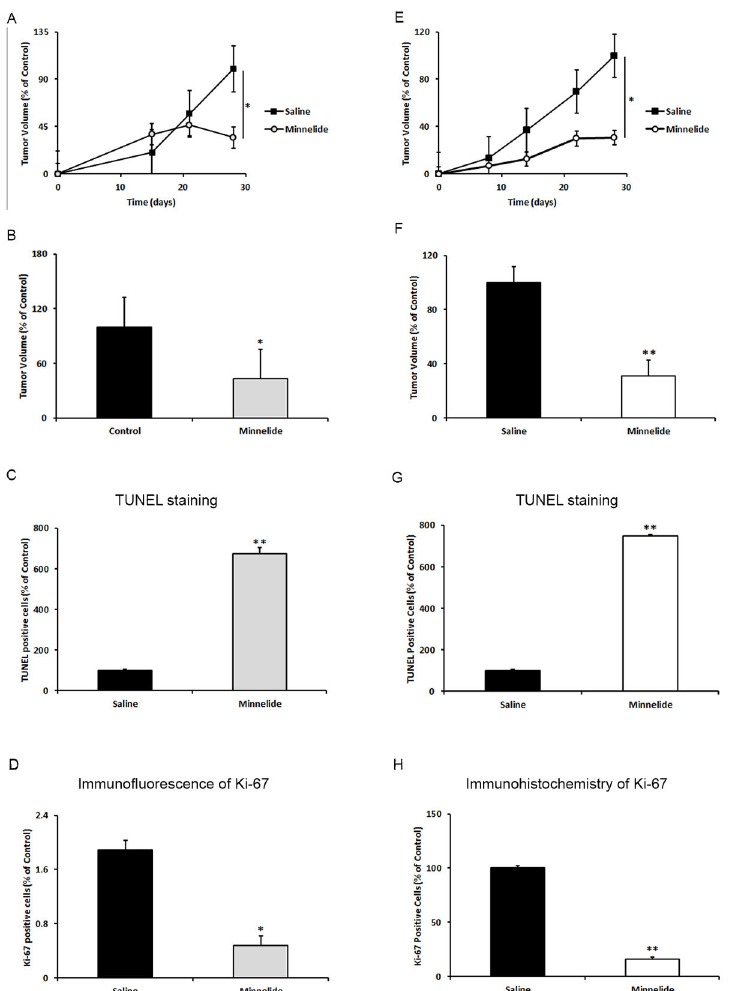
Figure 3. Minnelide leads to tumor regression in xenograft mouse models. In two xenograft mouse models, A549 (right panel) and NCI-H460 (left panel), tumor volumes were compared between minnelide treated (n = 10) and untreated groups (n = 10). Five days after tumor injection, mice began receiving daily intraperitoneal injections of minnelide at 0.42 mg/kg mouse weight. Control animals were injected with equivalent volumes of phosphate-buffered saline. Suppression of tumor growth occurred in the minnelide treated groups in comparison with the control groups in both xenograft models (A, E). Graphs (B and F) showed significantly decreased tumor volume from animals (A and E). Results were normalized to the untreated group for each cell line and expressed as the mean, Columns , bars , SE. Ki-67 protein expression was significantly decreased in the tumor tissue of minnelide treated group in both mouse models compare to saline treated groups (C and G). In concordance with decreased Ki-67 staining, TUNEL staining shown increased number of apoptotic cells in both mouse models (D and H). Columns , mean, bars , SE. Statistical significance of results was calculated with the Student`s t test (N=3) * P = 0.05; ** P =